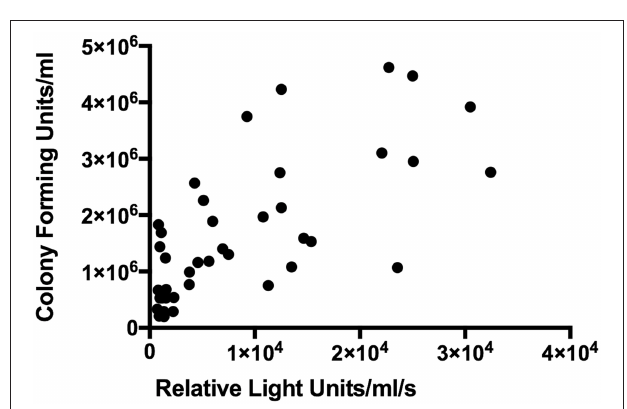
FIGURE 6 | Correlation between luminescence and colony forming units in BCG-GFP-LuxFO paediatric whole blood assay. n = 45 pairs of observations (samples from three experiments, from 9 children at 5 time points). Spearman rank correlation coefficient r = 0.7123 (95%CI: 0.5230–0.8346; p <